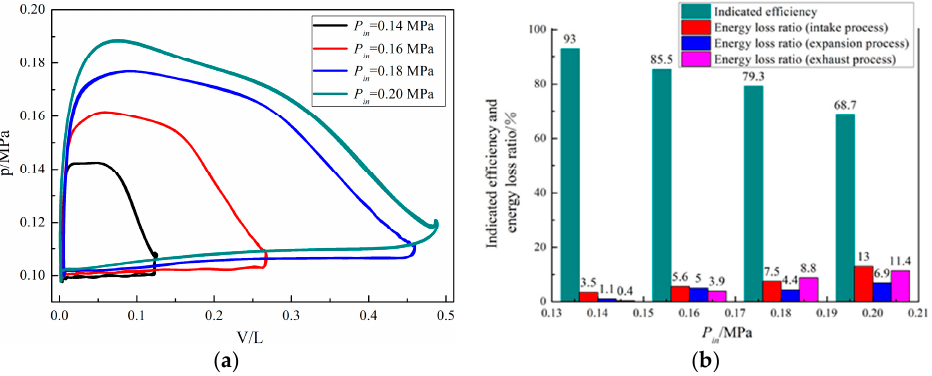
Figure 12. p – V diagram and indicated efficiency for different intake pressures: ( a ) p – V diagram for different intake pressures; ( b ) indicated efficiency and energy losses.